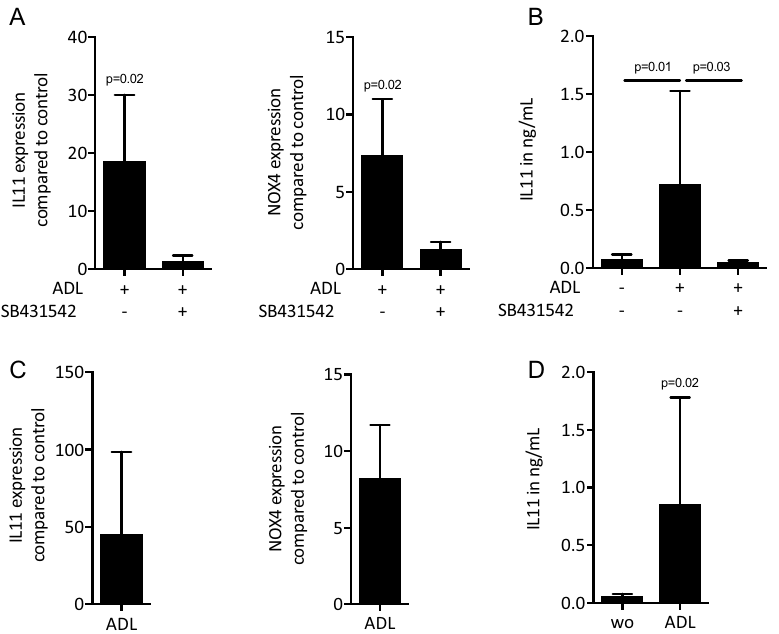
Figure 7. ADL-derived TGF-β activity absorbs to titanium surface and collagen membrane. Titanium discs were soaked in ADL for 1 h followed by three vigorous washes with phosphate buffered saline. Next, gingival fibroblasts were seeded onto the ADL coated titanium discs overnight with and without the inhibitor for the TGF-β RI kinase SB431542. Reverse transcription PCR analysis for ( A ) IL11 and NOX4 and ( B ) quantification of IL11 levels by immunoassay. Collagen membranes were treated with ADL for one h followed by three vigorous washes with buffered saline. Then, gingival fibroblasts were seeded onto the ADL-coated collagen membranes overnight. ( C ) Reverse transcription PCR analysis for IL11 and NOX4. ( D ) quantification of IL11 levels by immunoassay. N = 4–6. Data represent the mean ± SD. Statistic was based on two-tailed Mann-Whitney and Kruskal–Wallis test, for RT-PCR and immunosorbent assay,